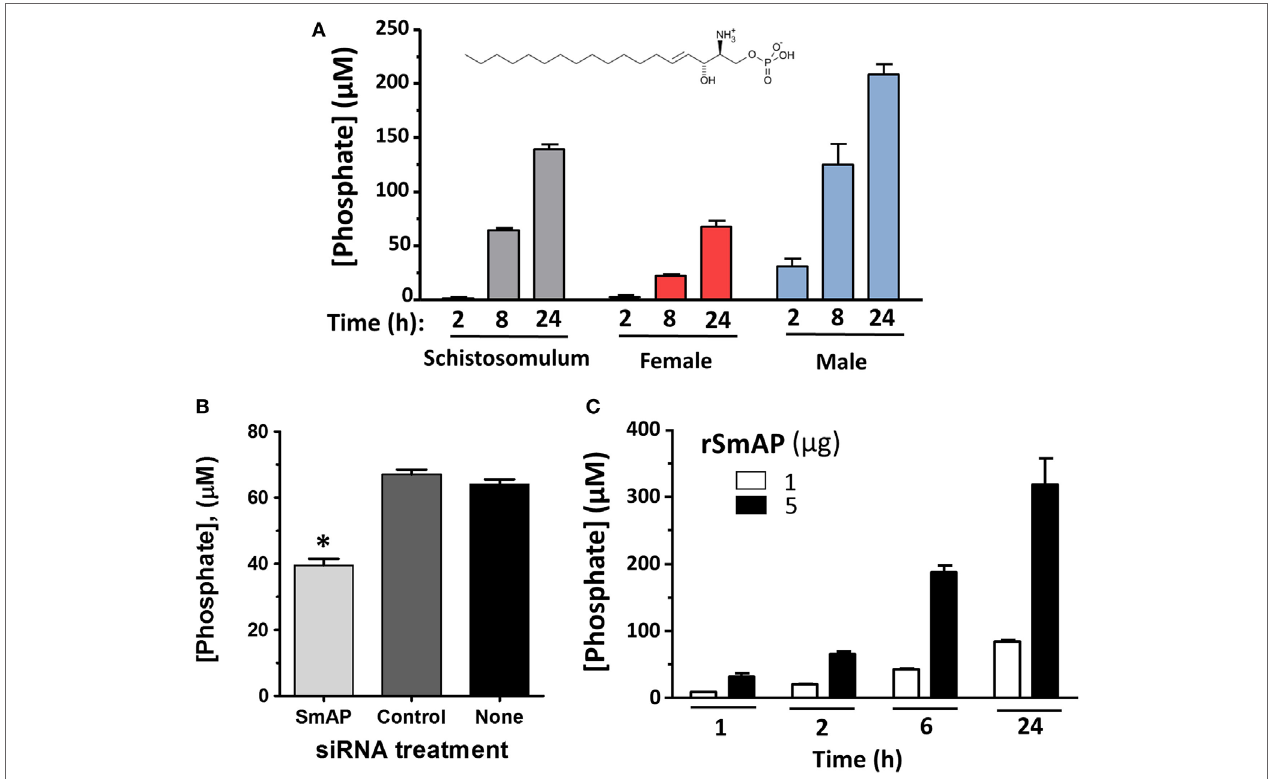
FigUre 6 | (a) Phosphate generation ( μ M, mean ± SD) by live schistosomula (groups of 1,000, gray bars) or individual adult females (red bars) or individual adult males (blue bars) in the presence of sphingosine-1-phosphate (S1P). The chemical structure of S1P is shown. (B) Phosphate generation ( μ M, mean ± SD) by individual live adult male worms 7 days after treatment with Schistosoma mansoni alkaline phosphatase (SmAP) siRNA or an irrelevant siRNA (Control) or no siRNA (None) in the presence of S1P. Parasites treated with SmAP siRNA generate significantly less phosphate compared to controls (*, one-way ANOVA, p <